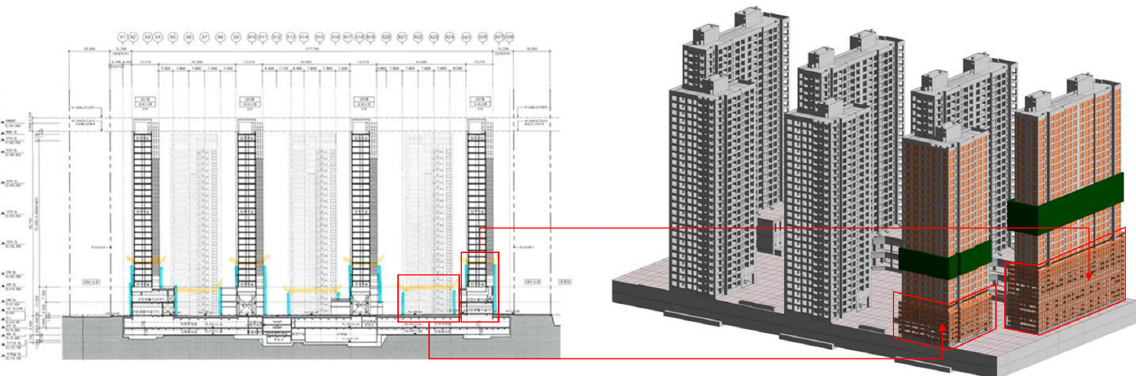
Figure 3. A case of BIM RFI: ( left ) visualization request for safety facility ( right ) visual representation using BIM model.